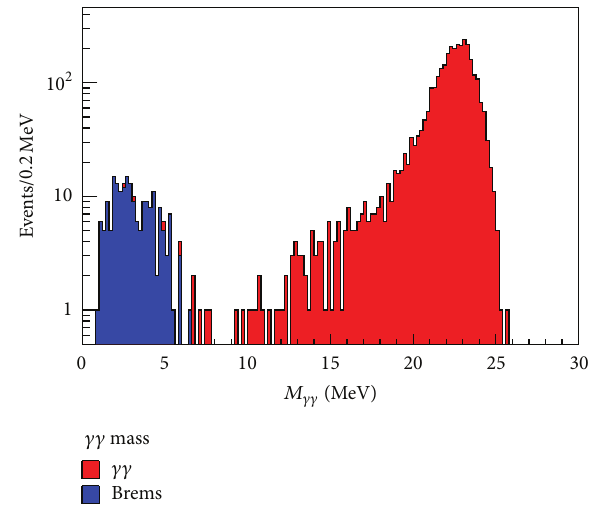
Figure 16: 𝑀 𝛾𝛾 mass distribution.